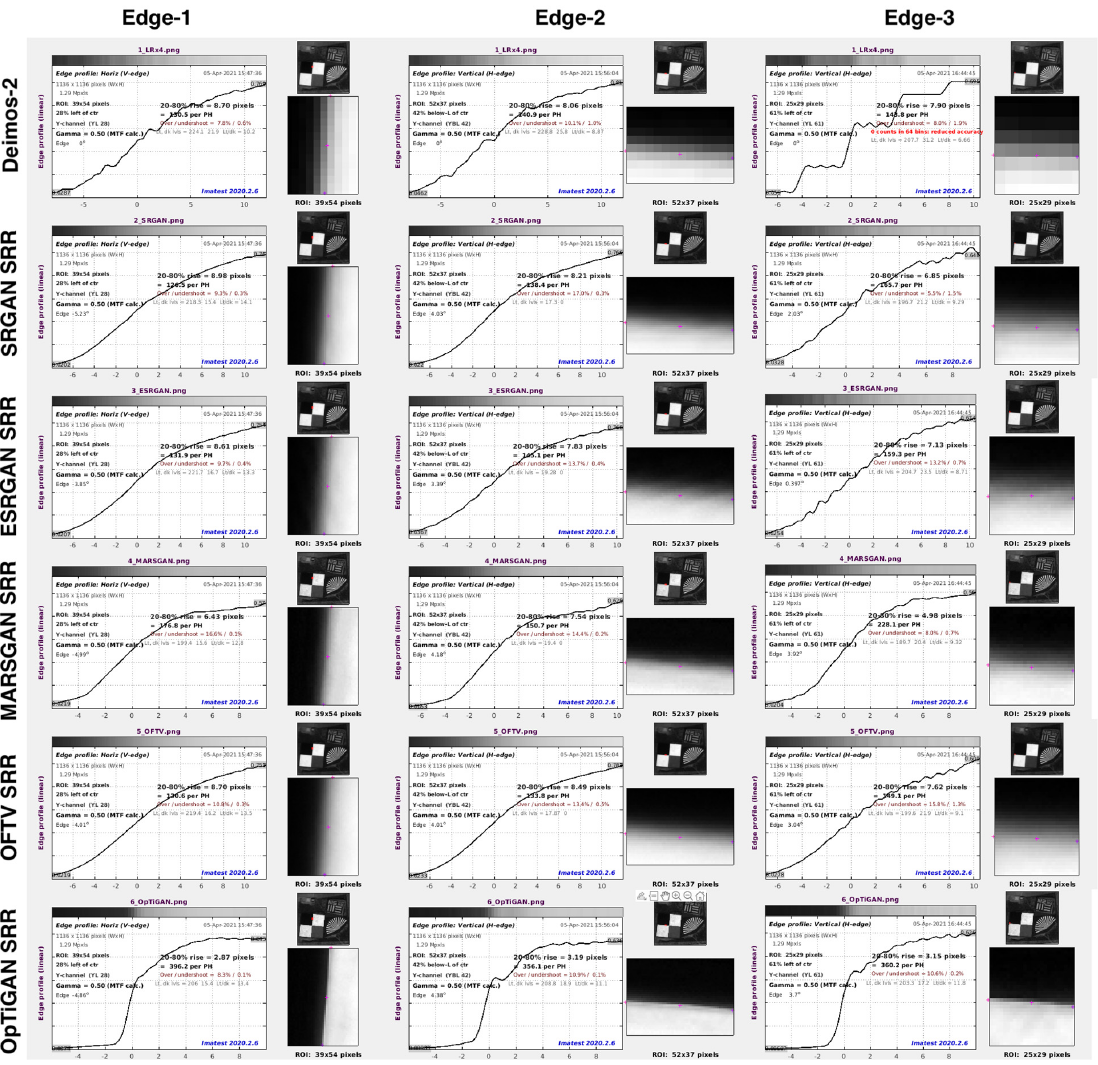
Figure 9. Imatest ® slanted-edge profile measurements for the knife-edge target at the Baotou Geocal site, showing 3 automatically detected edges for each of the input Deimos-2 image (upscaled by a factor of 4 for comparison), SRGAN SRR result, ESRGAN SRR result, MARSGAN SRR result, OFTV SRR result and OpTiGAN SRR result. For each slanted edge measurement, there is a plot, showing a profile line crossing the detected edge. Imatest ® measured the total pixel count of a 20–80% profile rise. For text inside the plots, please refer to the original full-resolution figure in Supplementary Materials. Deimos-2 image courtesy of Deimos Imaging, S.L. 2021.